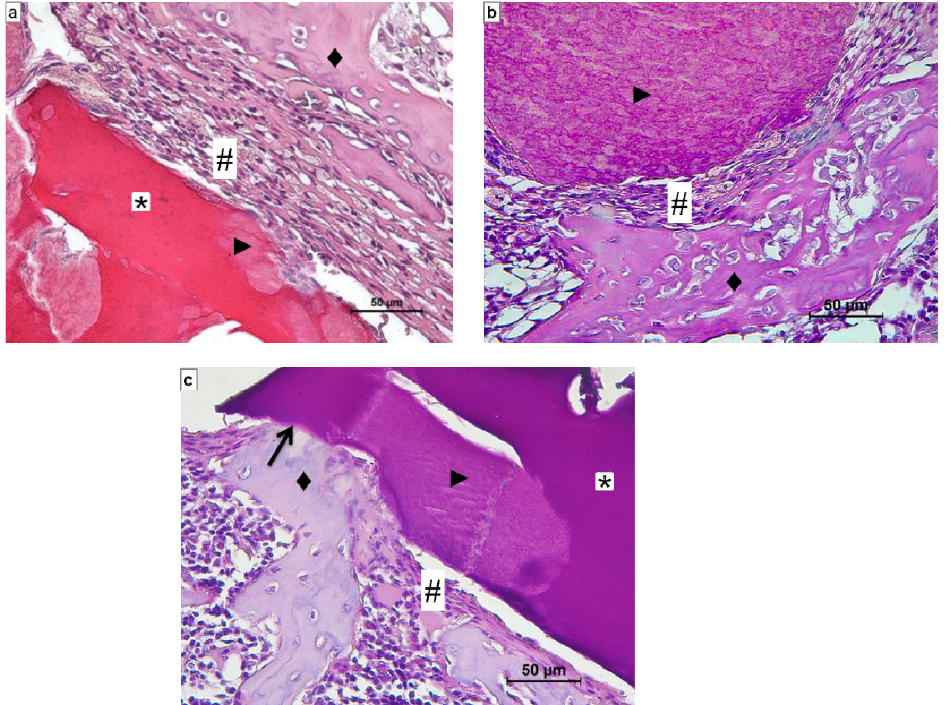
Figure 9 . Histological evaluation of CS/Sol-Si biocomposite at 14 days post-implantation. ( a , b ) Show at the tissue–biomaterial interface, the replacement of the clot by reparative granulation tissue (#) and formation of woven bone tissue ( (cid:7) ). ( c ) Shows osseointegrated woven bone tissue ( ↑ ). ( a – c ) Orig. Mag. × 400; H-E stain. (*) chitosan; ( ) silica